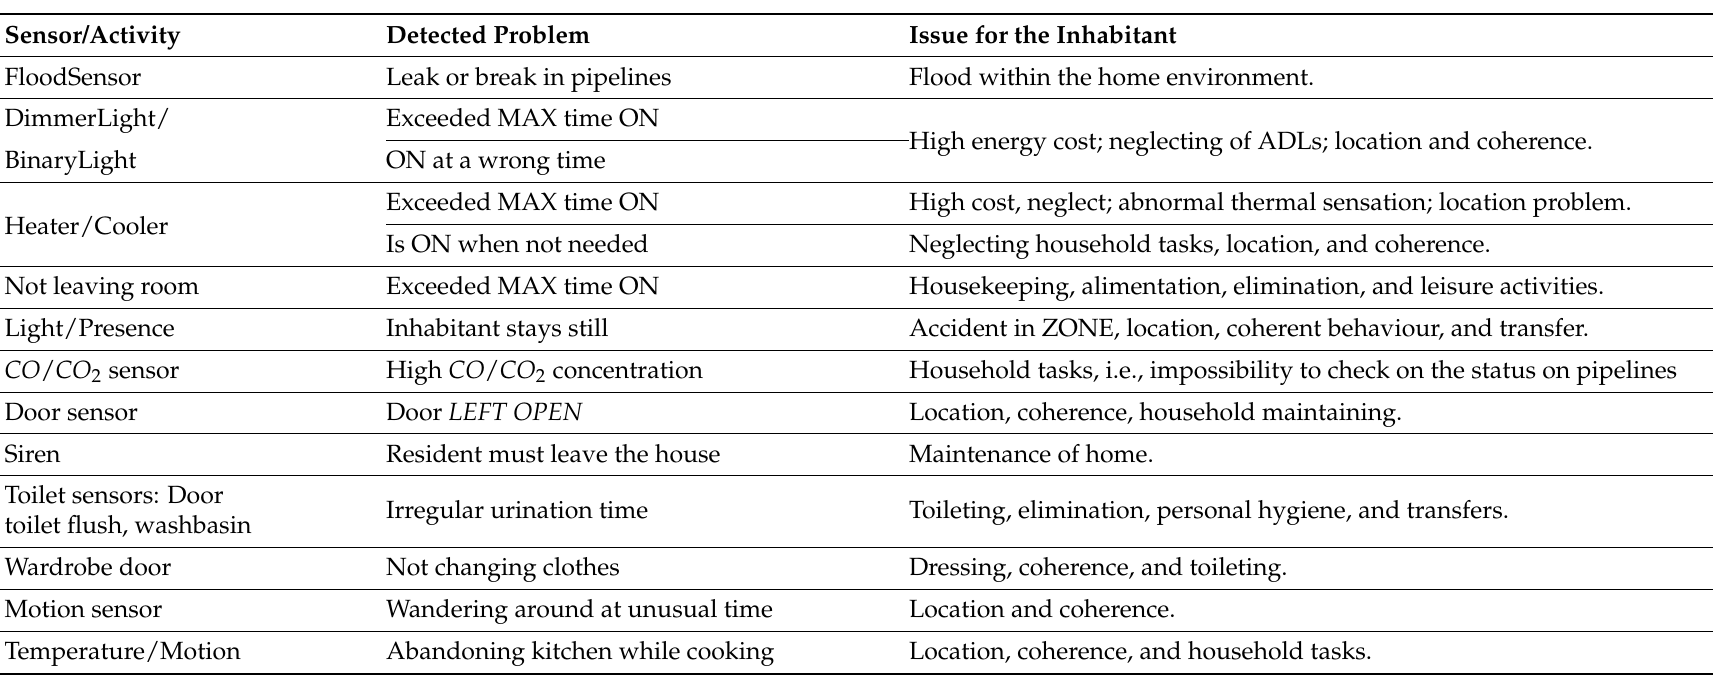
Table 16. Anomalies identified by the event detector